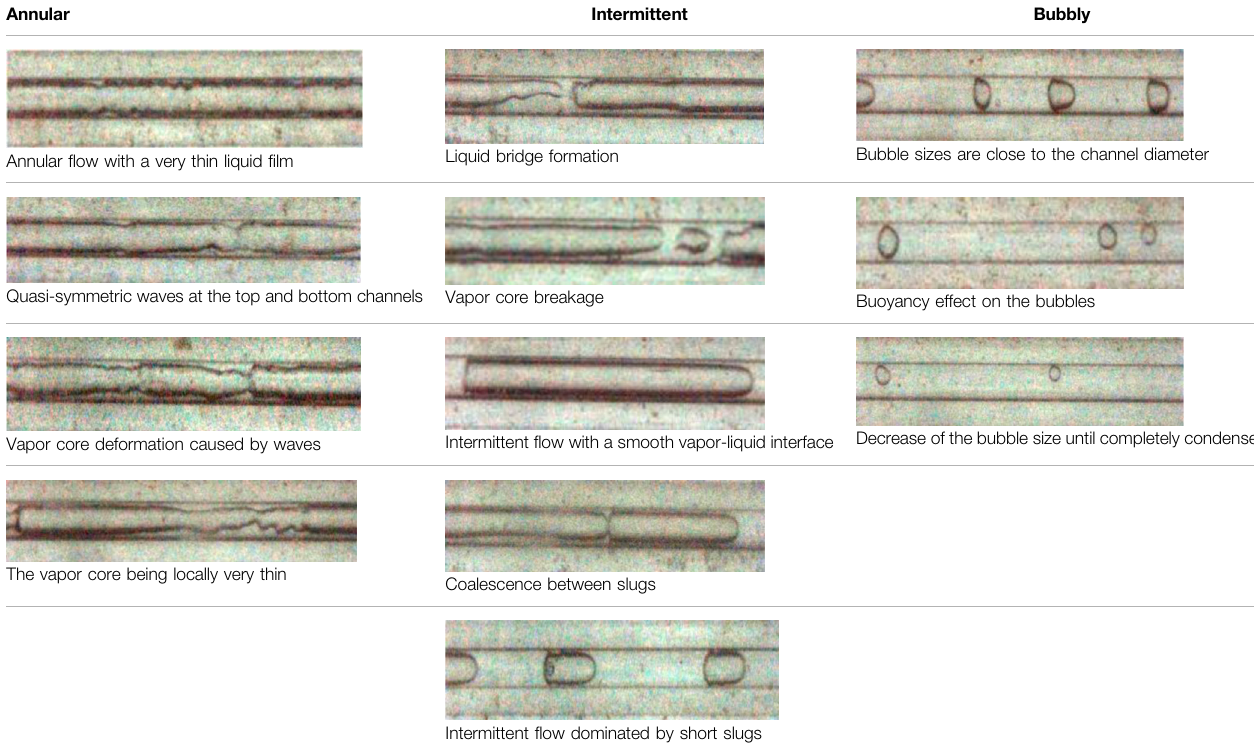
TABLE 3 | Flow regimes during condensation of R152a in a 0.75 mm circular minichannel.